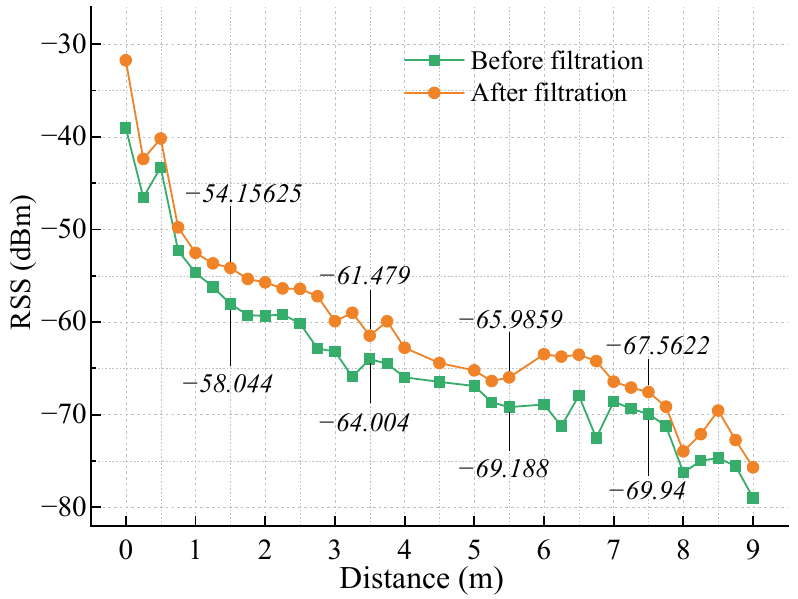
Figure 3. The RSS processing.